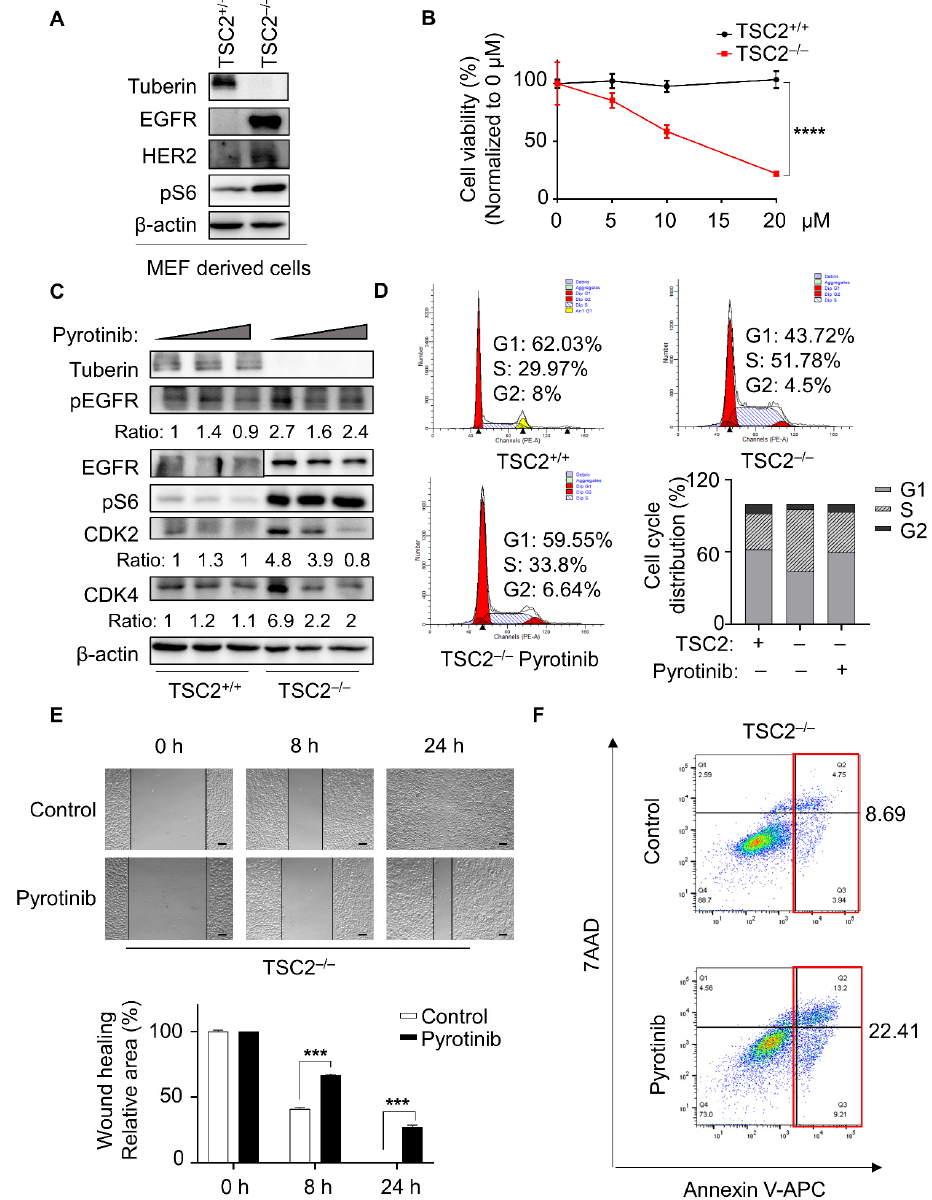
Figure 1. Pyrotinib specifically reduced cellular viability of TSC2-deficient cells. ( A ) MEF-derived cells with or without TSC2 expression were lysed, and indicated proteins were detected by im- munoblot. ( B ) MEF-derived cells were dealt with different concentrations of pyrotinib for 48 h, and cell viability was monitored using the CCK8 assay ( n = 6), the half maximal inhibitory concentration (IC50) was calculated after pyrotinib treatment in TSC2-deficient cells (IC50 = 11.5). **** p < 0.0001, TSC2 +/+ versus TSC2 − / − at 20 µ M, Student t test. ( C ) Immunoblot analysis of MEF-derived cells treated or not treated with pyrotinib (1 µ M or 5 µ M). ( D ) Cell cycle distribution was detected in MEF-derived cells treated with or without pyrotinib (1 µ M), fluorescence signals were collected by flow cytometry. ( E ) TSC2-deficient cells grown to confluent monolayer were scratched and treated with pyrotinib (1 µ M) for 8 h and 24 h. Representative images at the 0, 8 and 24 h time points are shown (magnification 40 × , bar = 200 µ m) *** p < 0.001, control vs. pyrotinib at 8 h or 24 h, Student t test. ( F ) TSC2-deficient MEF-derived cells were treated with pyrotinib (1 µ M) for 48 h. Annexin V: FITC Apoptosis Detection Kit (MULTI SCIENCES) was used to stain cells. Anoikis was determined by flow cytometry. Annexin V + /7AAD + indicated cells undergoing late apoptosis and Annexin V + /7AAD − indicated early